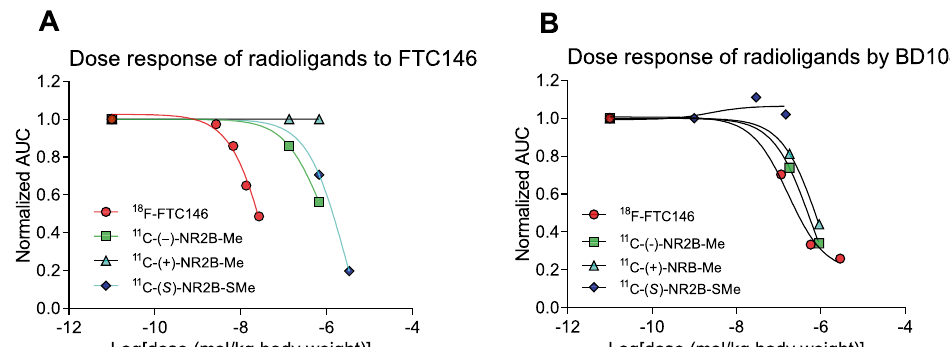
Fig. 5 Rat whole brain uptake dose response for σ1 receptor radioligand 18 F‑FTC146 and GluN2B radioligands 11 C‑( and 11 C‑( S )‑NR2B‑SMe to intravenous pre‑administration of FTC146 ( A ) and BD1047 ( B ). Derived ED 50 values are given in Table 3